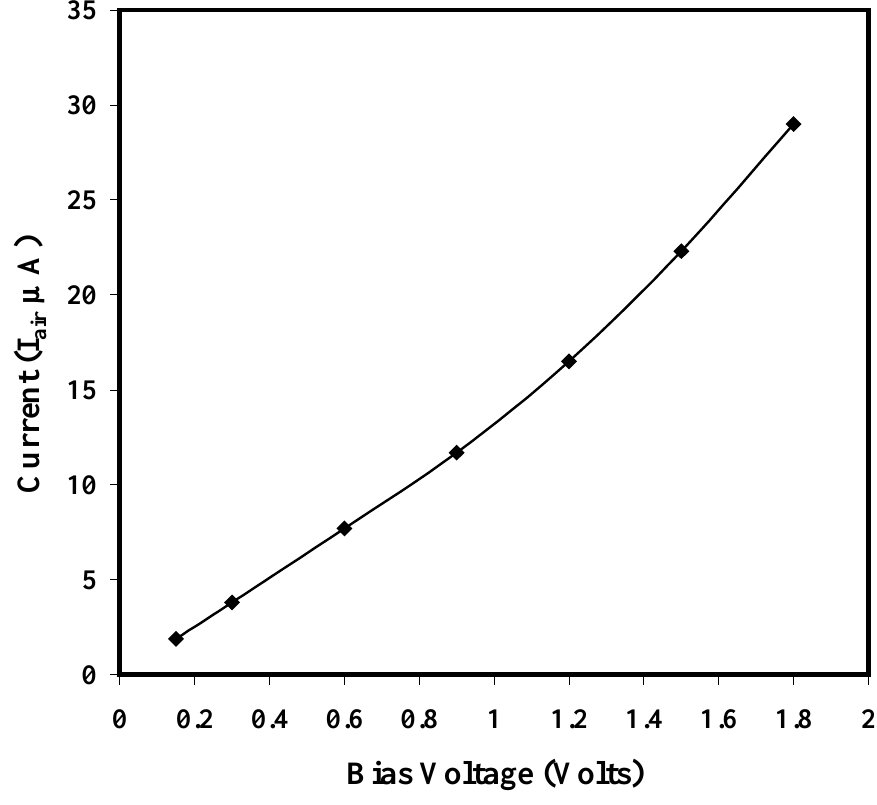
Figure 3. Current voltage characteristics of SnO